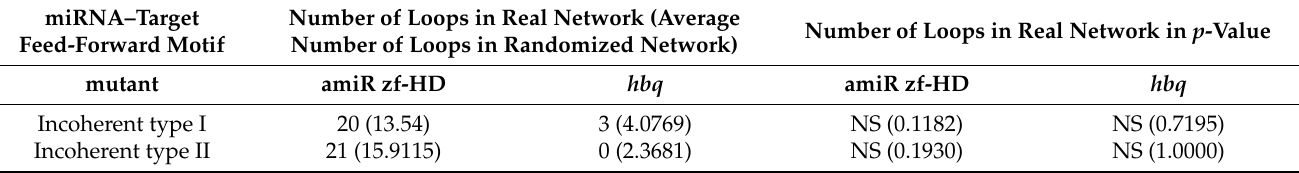
Table 1. Network motif analysis comparing Col-0 and zf-hd